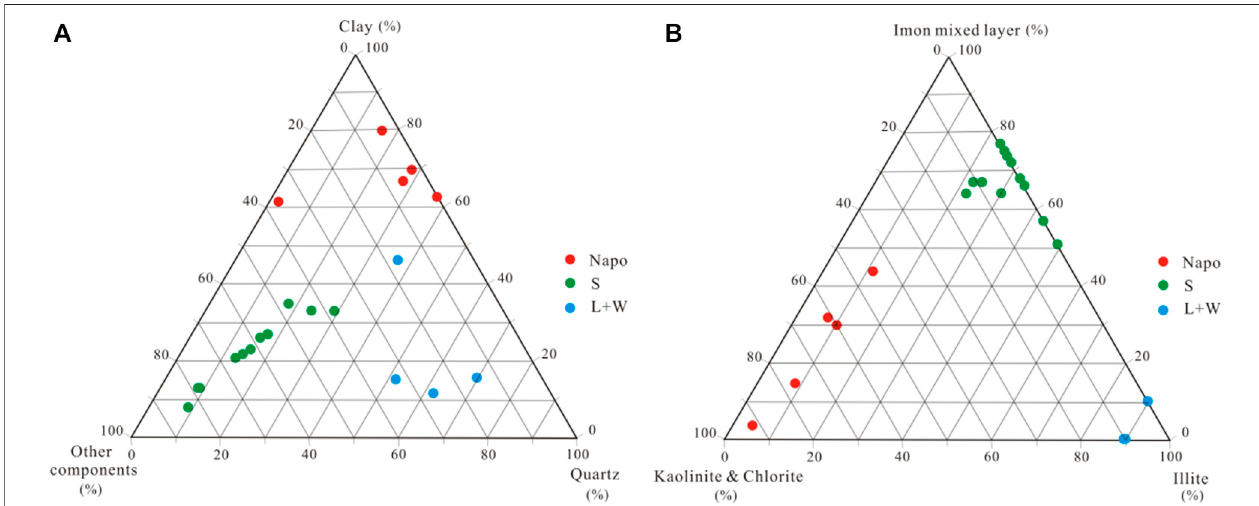
FIGURE3| Mineralcompositionandcontentoftheshalesamples.Notes: “ Napo ” -NapoFormationshalesinOrientBasin; “ S ” -ShahejieFormationshalesinBohai Bay Basin; “ L + W ” - Longmaxi and Wufeng Formation shales in Sichuan Basin.